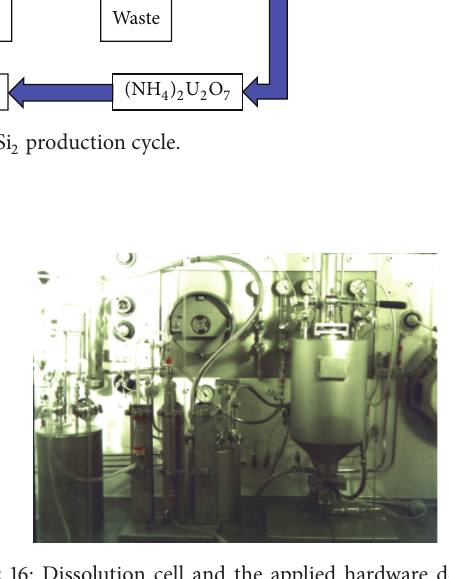
Figure 15: Irradiated silicide-based fuel targets prior to starting the dissolution process at KFK.